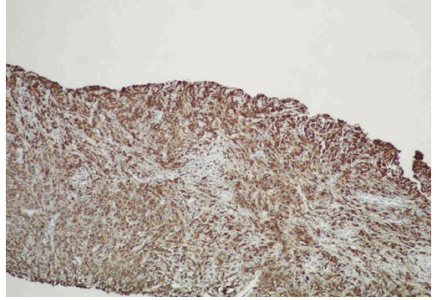
Figure 1: Note the diffuse eosinophilic histiocytes infiltration in prostate tissue and presence of intracytoplasmic basophilic inclu- sions (HE × 200).